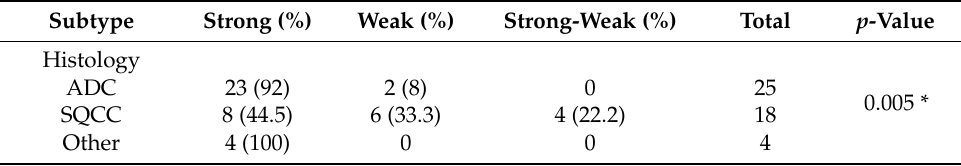
Table 2. CXCR7 expression in lung cancer